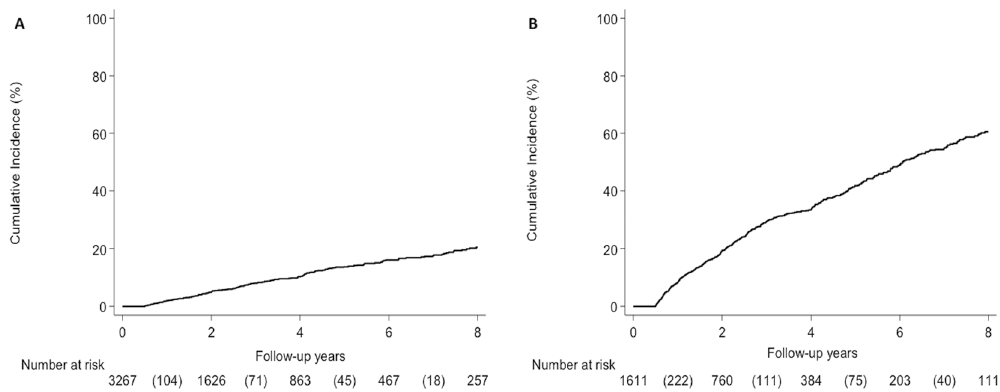
Figure 1. Development rate of ( A ) hepatocellular carcinoma and ( B ) hepatic